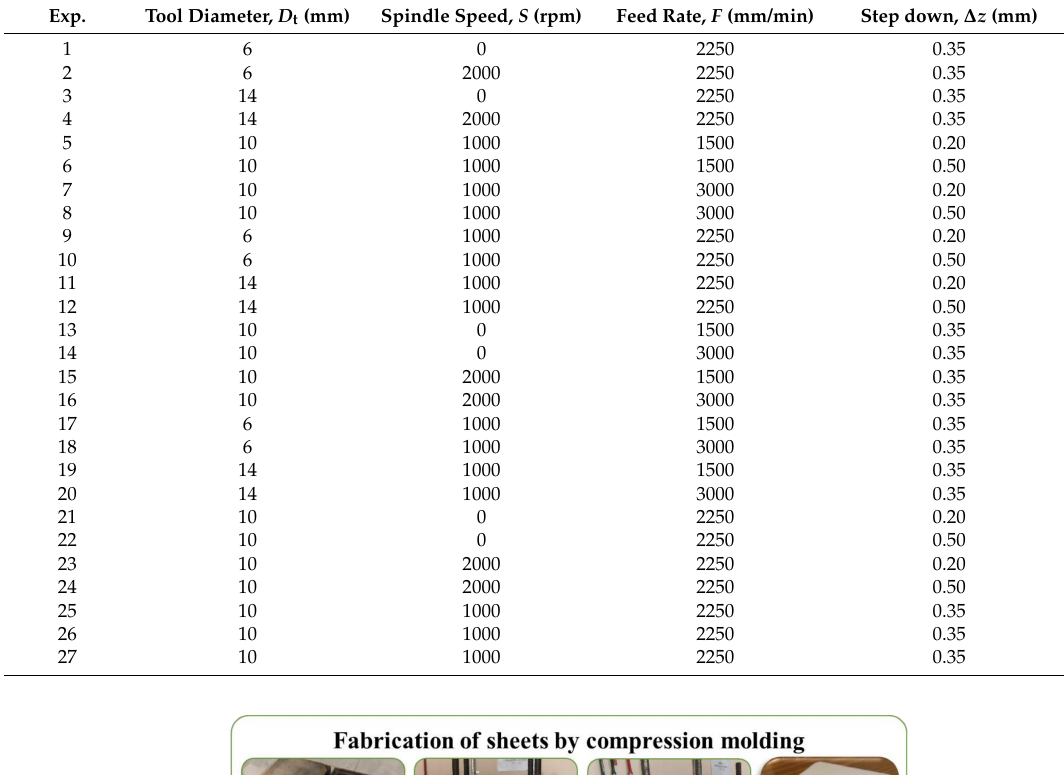
Table 2. List of 27 experiments for SPIF of PCL and UHMWPE sheets.